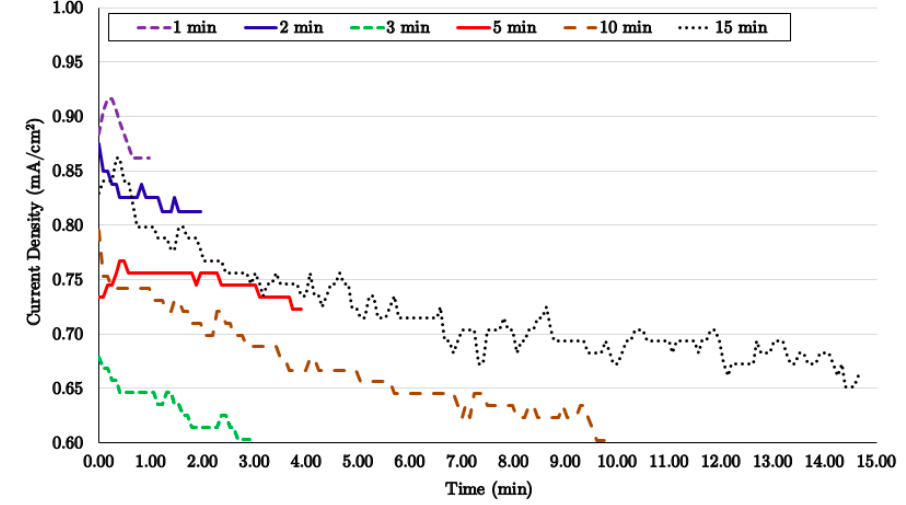
Figure 8. Effect of EPD time on deposition of CNTs on the glass fibers.